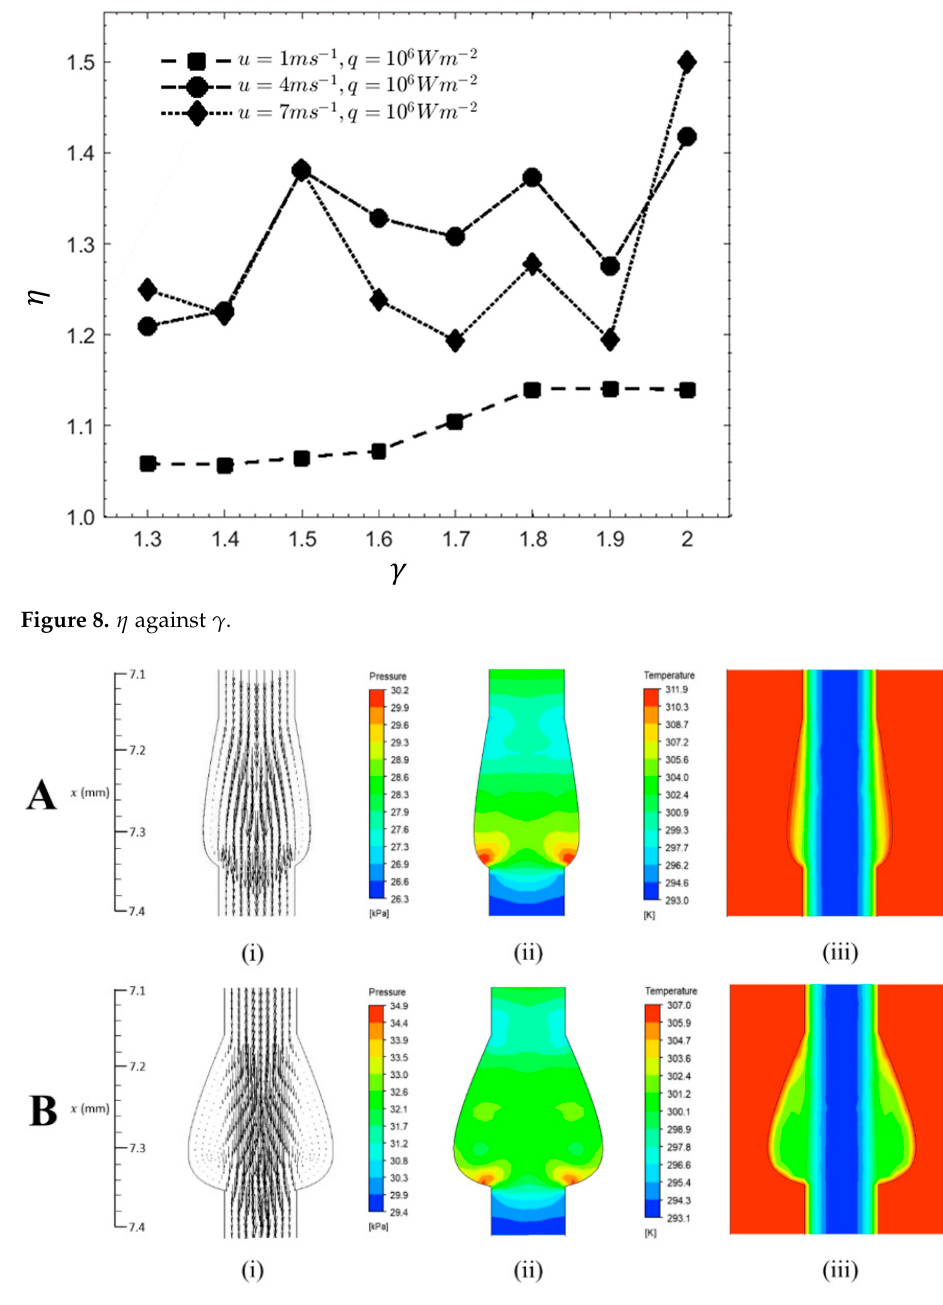
Figure 9. ( i ) velocity vectors, ( ii ) pressure contour and ( iii ) temperature contour for the micro ‐ channel with parameters at ( A ), 𝛽 (cid:3404) 0.5 , γ (cid:3404) 1.4 , and 𝛿 (cid:3404) 0.75 , and at ( B ), 𝛽 (cid:3404) 0.5 , 𝛾 (cid:3404) 2.0 , and δ (cid:3404) 0.75